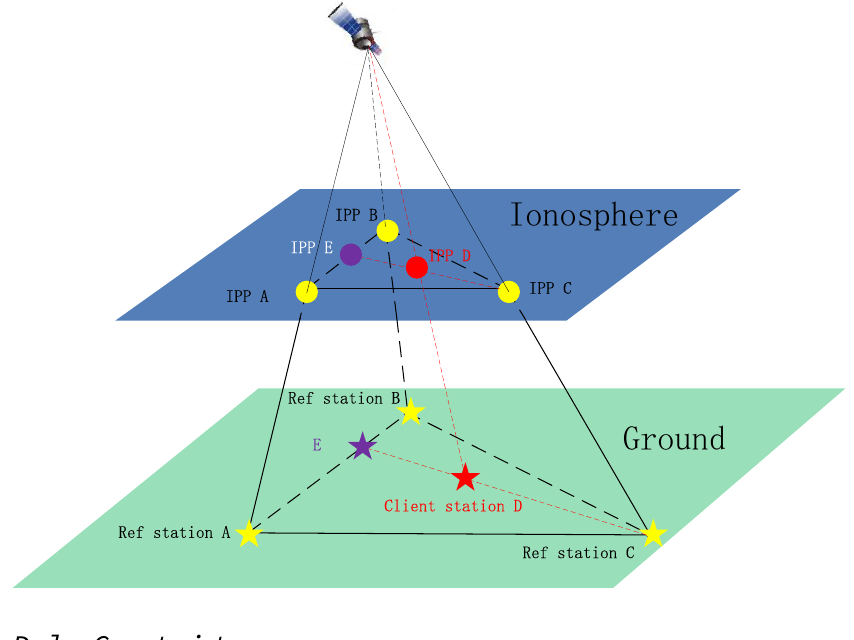
Figure 1. Interpolation of the slant ionospheric delay of a client station using the estimated slant delays of three closest reference